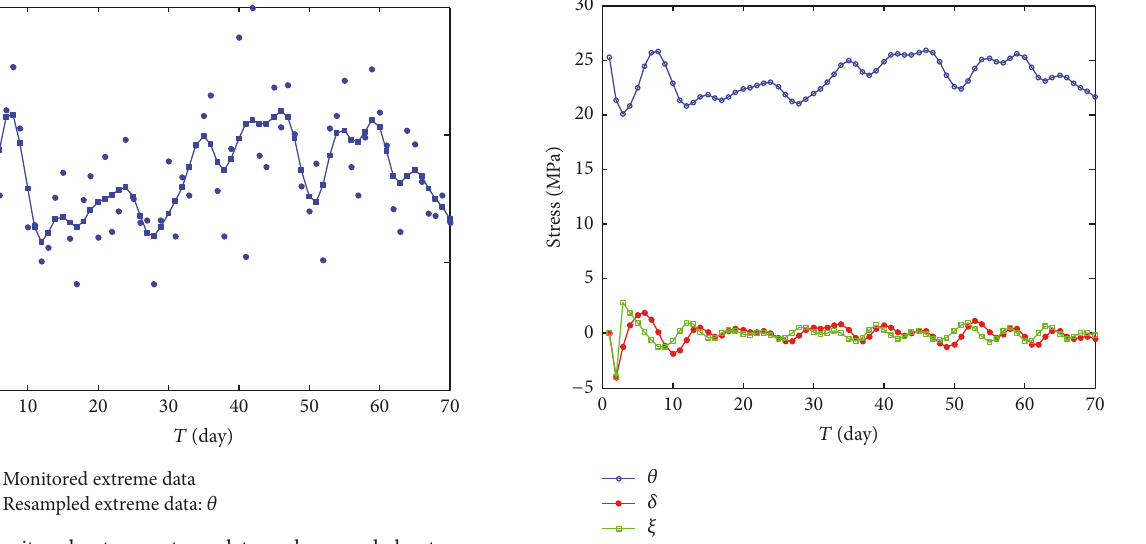
Figure 7: Initial state data and initial state difference